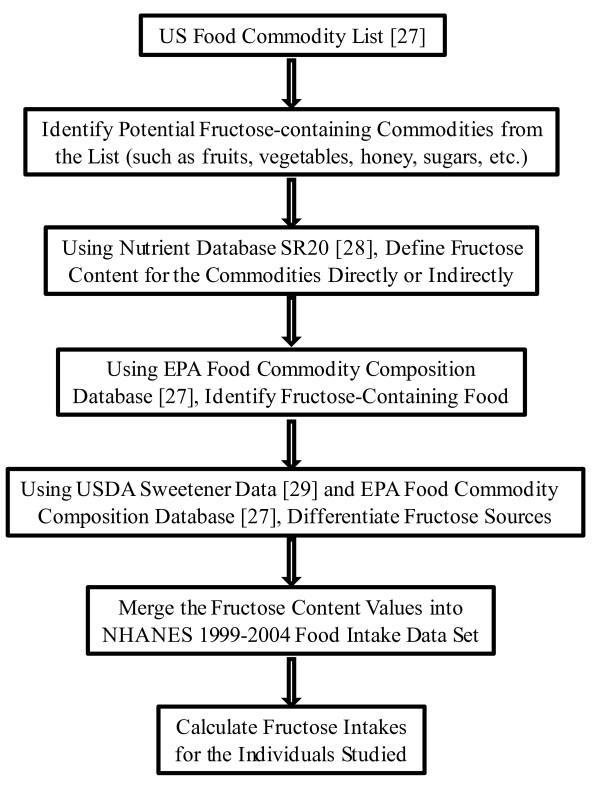
Flow Chart for Individual Fructose Intake Calculation.